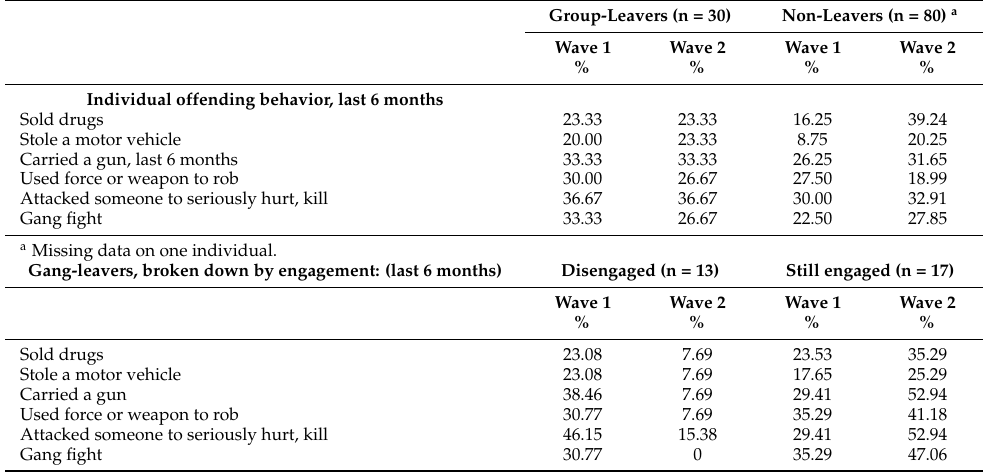
Table 6. Reasons for Leaving a Self-Reported Group-Leavers, Disengaged vs. Engaged.